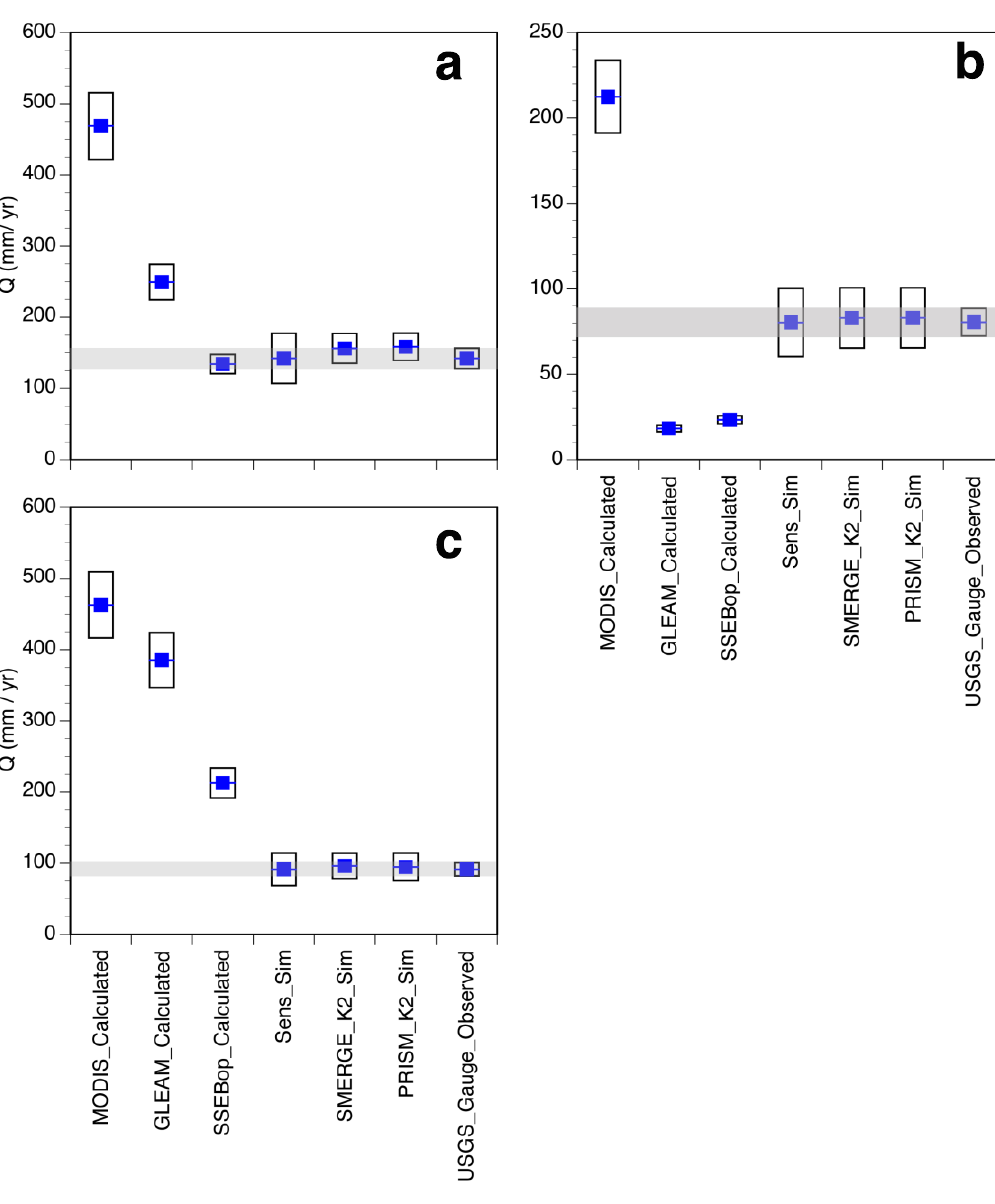
Figure 7. Same as Figure 5. ( a ) LA-2016, ( b ) LA-2017, and ( c ) LA-2018.